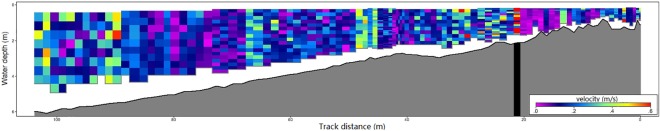
The current velocity in the west bank of the transection.